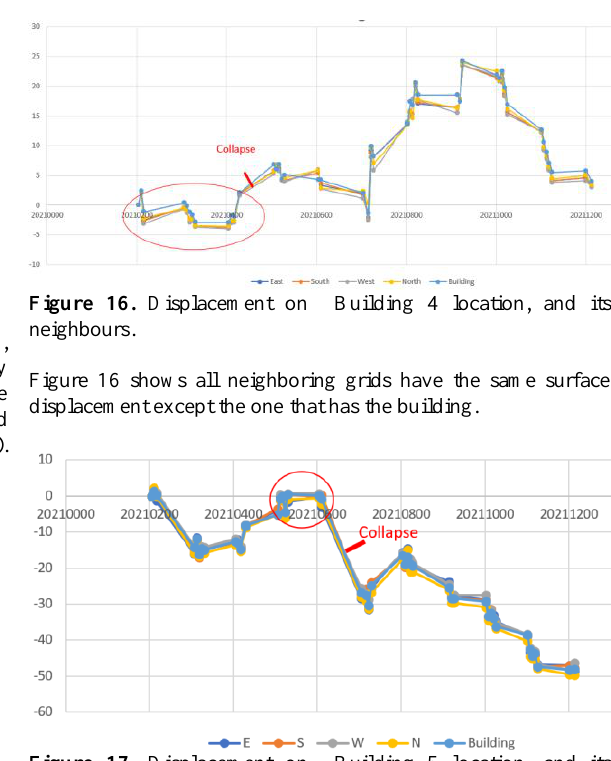
Figure 13. The displacement plots of the building 1 with its neighbours.